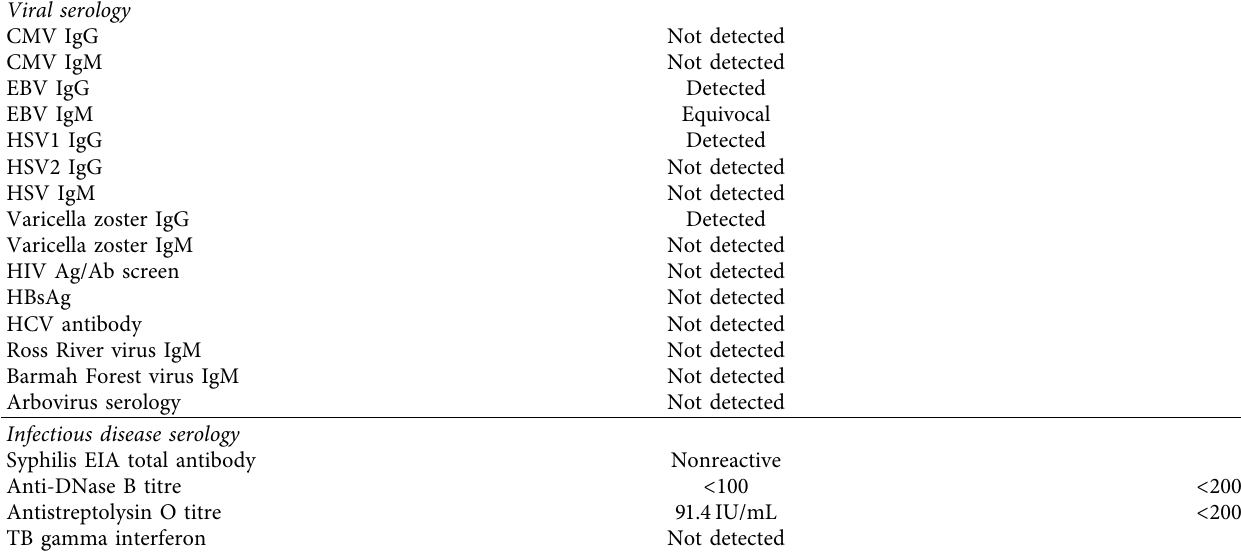
Table 3: Viral and infectious diseases serology.